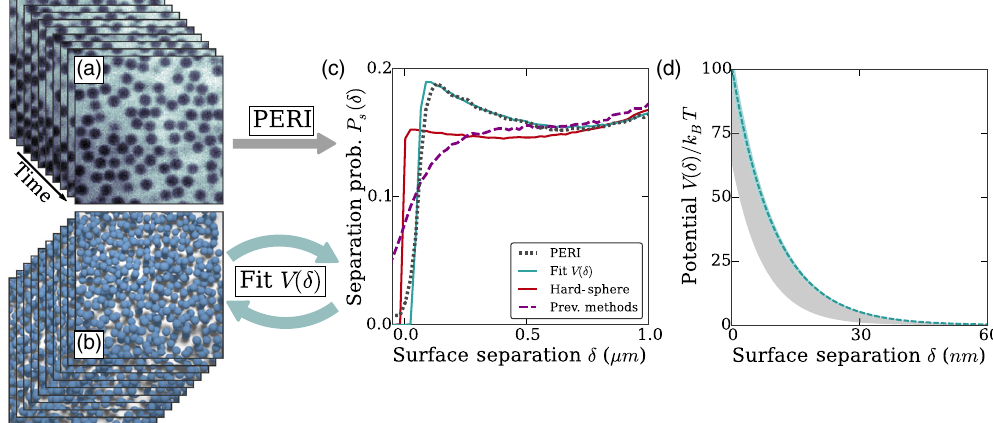
FIG. 3. Extracting interparticle potentials . (a) We use PERI to analyze a large ensemble of three-dimensional images of a dilute suspension of approximately 1200 Brownian particles; a small section of these images is shown in the upper left. From these data, we ð δ Þ . (b) We use molecular dynamics to create a simulated P ð δ Þ , and we iteratively update the interaction extract an experimental P s s ð δ Þ that best fits the experimental data. (c) The extracted P ð δ Þ from PERI (gray dashed line) and from the potential V ð δ Þ to find the P s s ð δ Þ from a strictly hard-sphere potential (red line) does not fit the fitted potential (solid cyan line) agree excellently. In contrast, the P s data. The difference between these potentials depends on resolving particle separations at the nanometer level. Previous centroid-based ð δ Þ with nonsensical features, such as significant overlaps, that cannot be fit by a reasonable methods [41] (purple line) produce a P s ð δ Þ in SM [18], Sec. VII. (d) From the best-fit simulation, we extract interaction potential. We discuss the overlaps in PERI ’ s extracted P s the interparticle potential V ð δ Þ . The shaded bands show the uncertainty in the potential, with the teal band describing uncertainty in the fit and the gray band the uncertainty due to systematic errors (see SM [18] for further